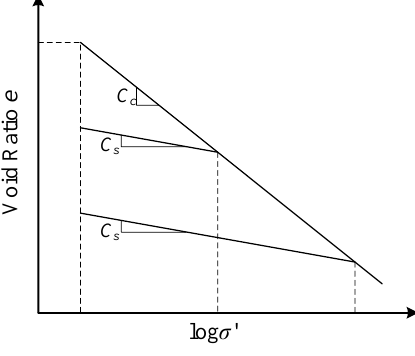
Figure 1. The diagram of e -log σ′ relation.